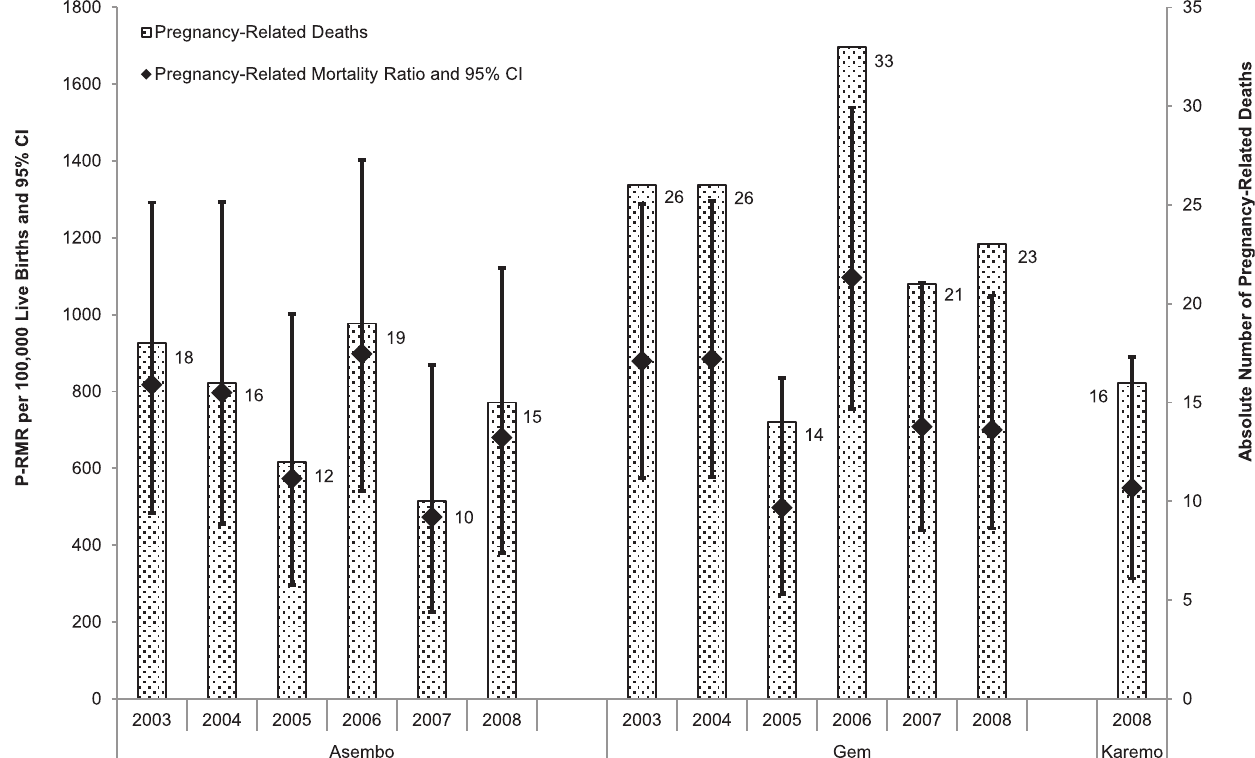
Figure 1. Pregnancy-related mortality ratio in women 15–49 years by year of death and area. doi:10.1371/journal.pone.0068733.g001 PLOS ONE |